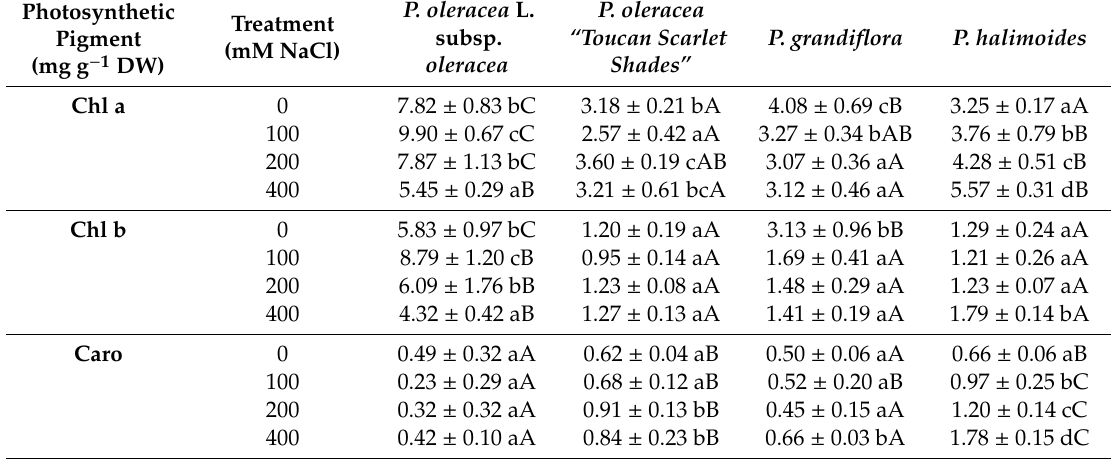
Table 1. Photosynthetic pigments in the leaves of the four studied Portulaca genotypes. Chlorophyll a (Chl a), chlorophyll b (Chl b) and carotenoids (Caro) contents after 5 weeks of applied salt stress. Values shown are means ± SE. For each pigment, di ff erent lowercase letters in a column indicate significant di ff erences between treatments; di ff erent capital letters in a row denote significant di ff erences among the genotypes undergoing the same